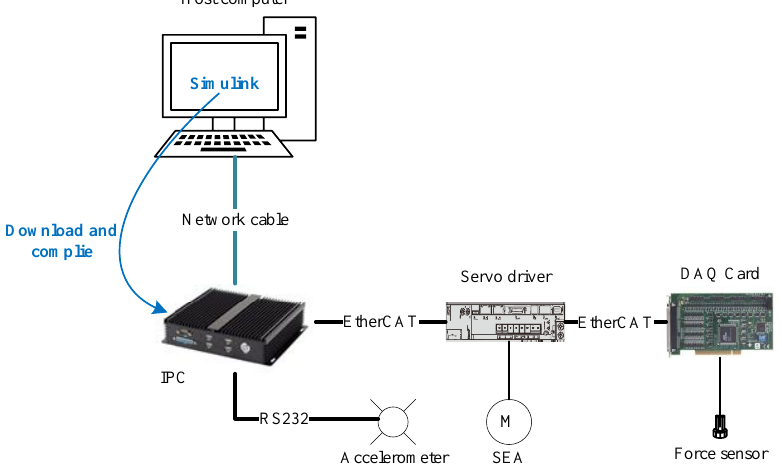
Figure 13. The system controller scheme.